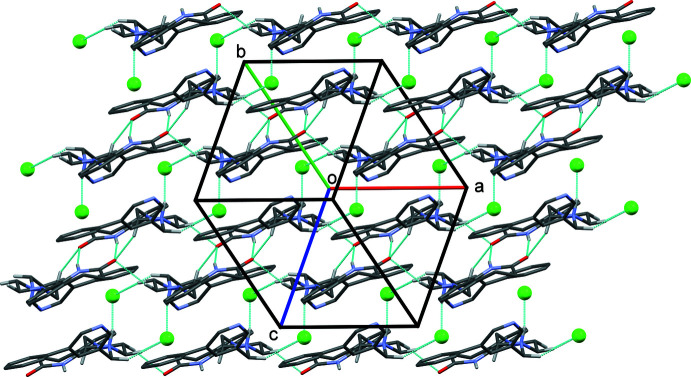
A view along the [111] direction of the crystal packing of salt I·HCl. Hydrogen bonds are shown as dashed lines (see Table 1 ▸).